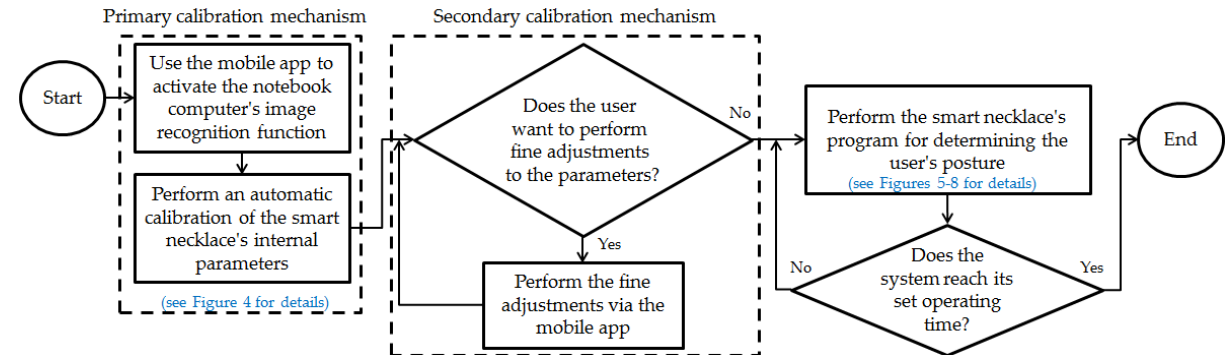
Figure 2. Outline flowchart of the overall system's operations.